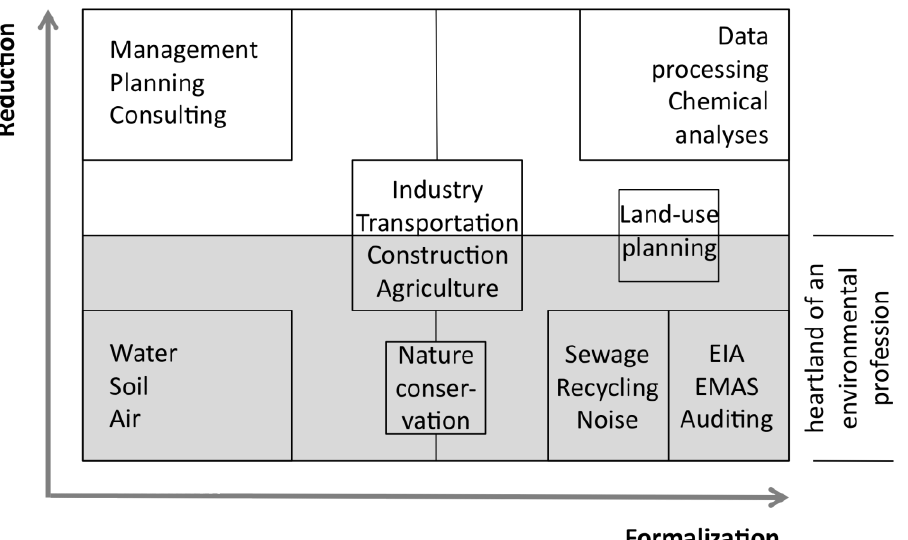
Figure 1. The 1997 model of the field of environmental tasks: Reduction and for- malization as two dimensions that define the field of environmental tasks in Switzerland. Here, formalization is defined as degree of professional standardiza- tion (not scientification, mathematization,